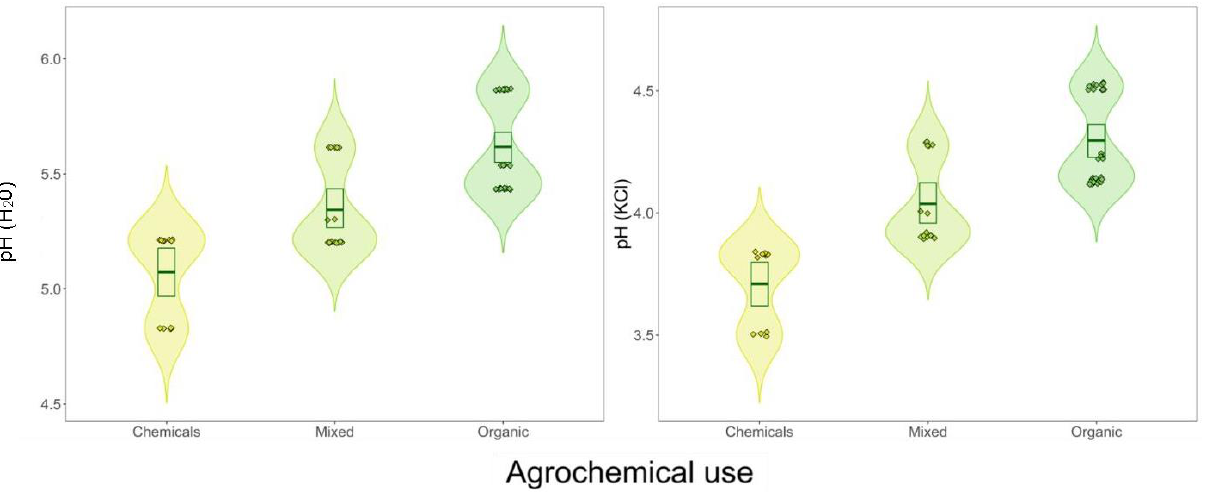
Figure 2. pH of soil samples from 56 coffee home gardens in West Java in relation to the use of chemicals. Data are model predicted values from generalised linear models, and boxes dictate 95% confidence intervals. Table 1. Pairwise ratios of soil components between treatments in relation to agrochemical use